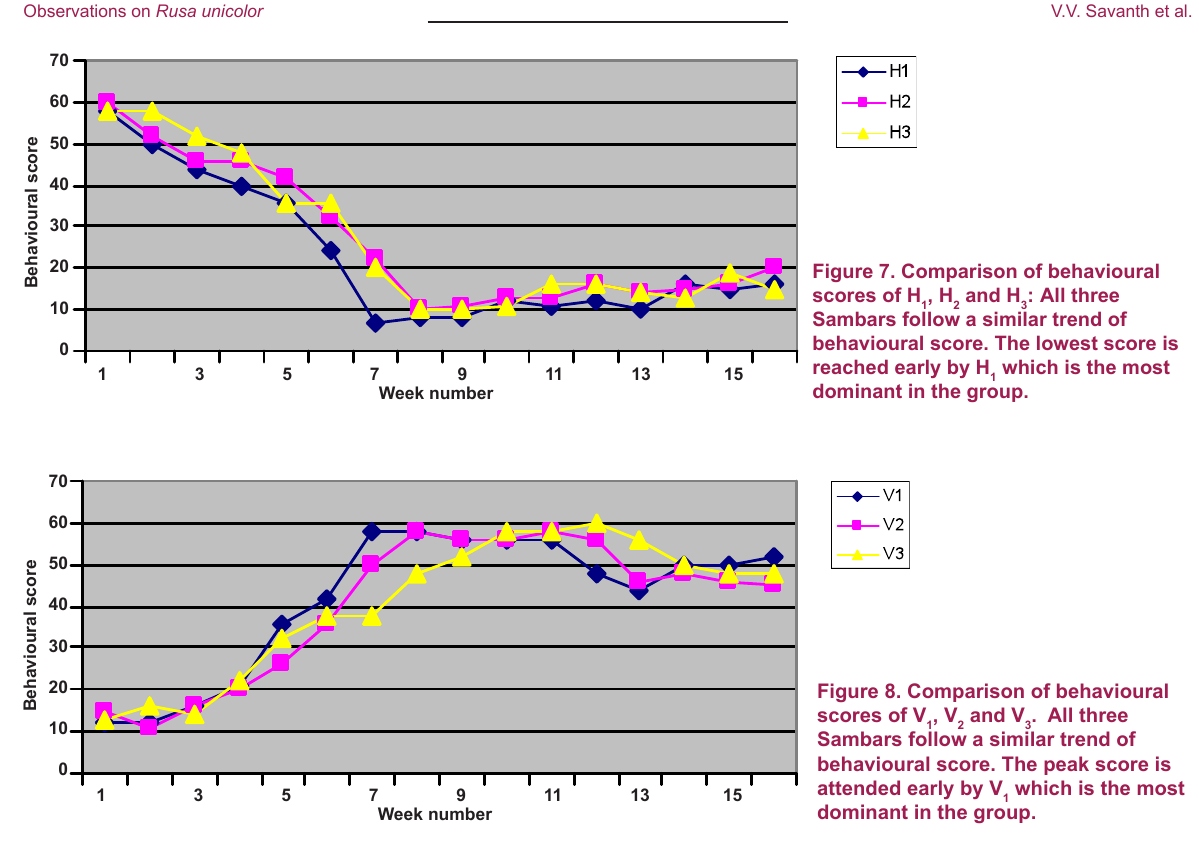
Figure 8. Comparison of behavioural scores of V , V and V . All three 1 2 3 Sambars follow a similar trend of behavioural score. The peak score is attended early by V which is the most 1 dominant in the